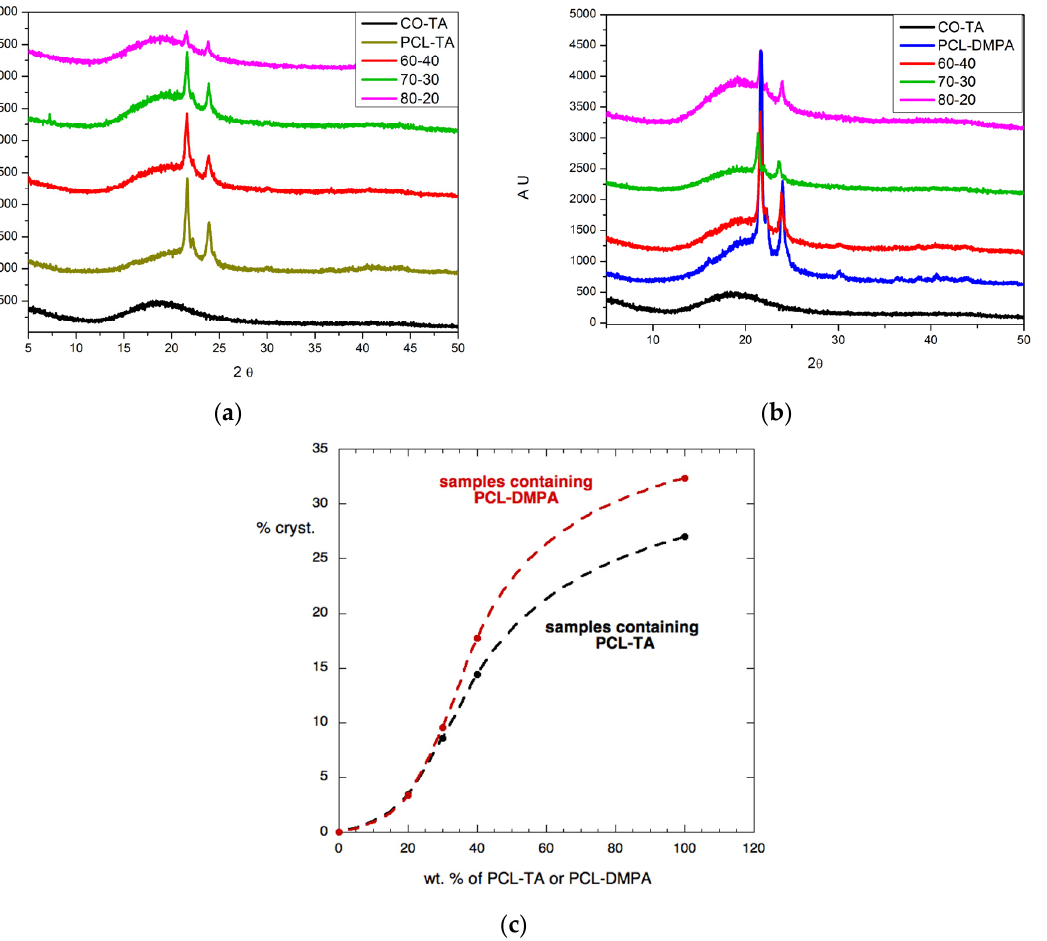
Figure 4. Diffraction patterns of samples containing different contents of PCL-TA ( a ) and PCL-DMPA ( b ). Effect of the content of PCL-based WBPUs on the crystallinity of the samples ( c ). Lines are drawn as guides to the eye.